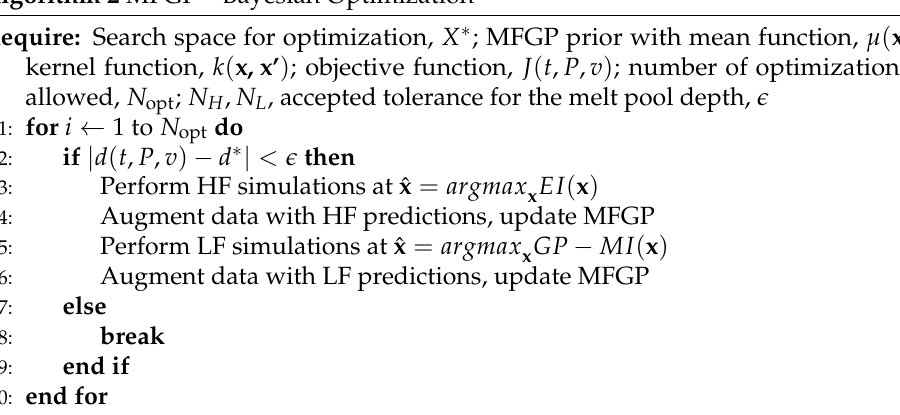
Algorithm 2 MFGP—Bayesian